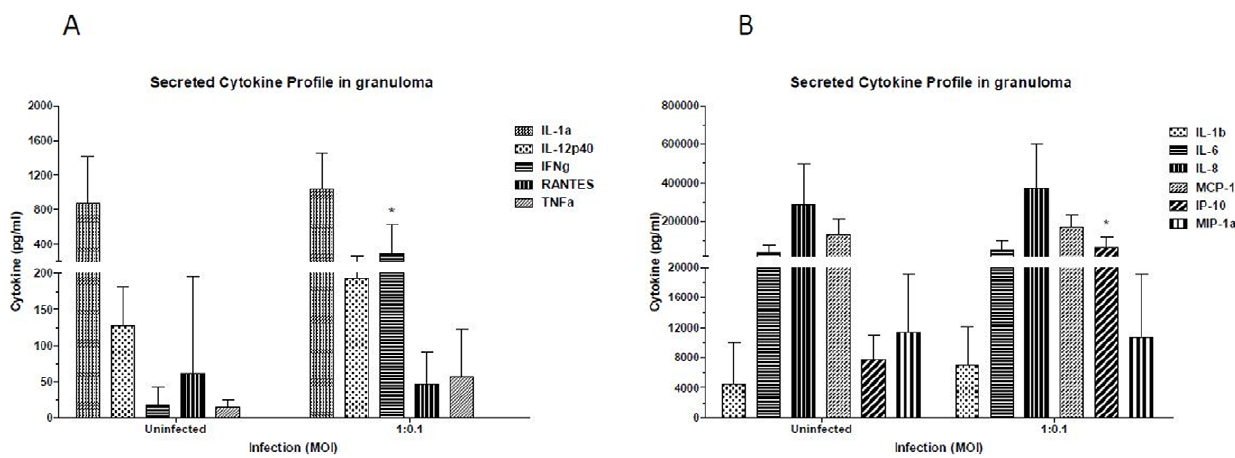
Figure 3. Infection of human PBMCs with Mtb induces inflammatory Cytokines. Supernatants from granuloma samples or control uninfected samples were saved at 8-day post-infection and cytokine/chemokine profile determined by multiplex cytokine analysis as described in methods. Profiles for prominent cytokines and chemokine IL-1 a , IL-12p40, IFN- c , RANTES and TNF a are shown in Figure 3A, whereas Cytokines and chemokines IL-1 b , IL-8, IL-6, MCP-1, IP-10, MIP-1 a are shown in Figure 3B. Data are represented as mean + / 2 SEM from 3 experiments.